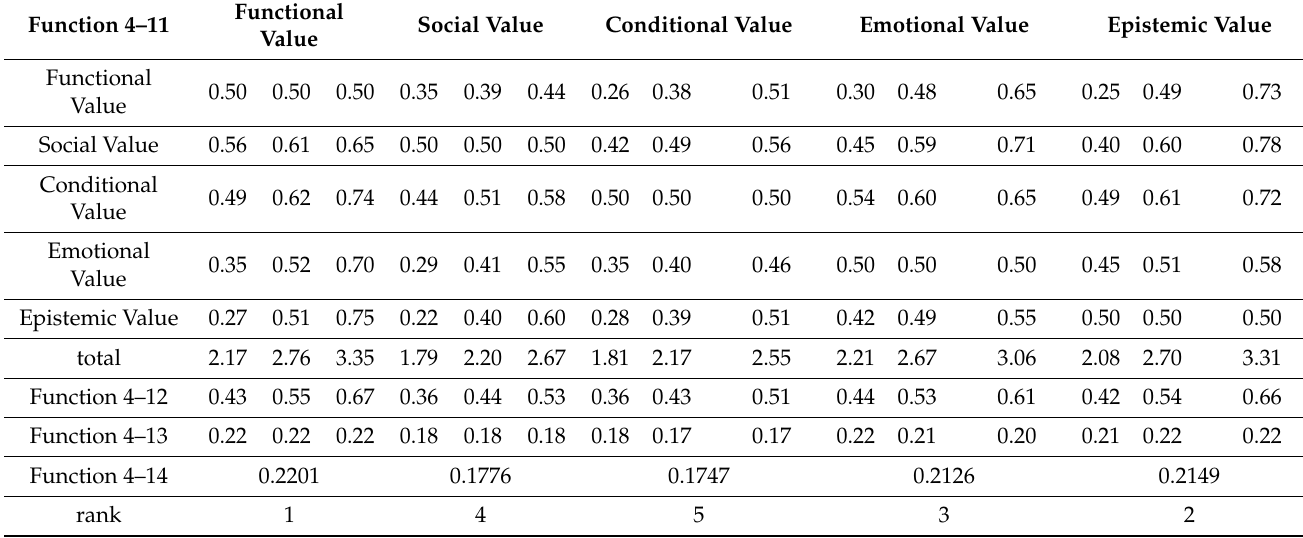
Table A14. Hotels’ weights of aspects of the service quality.